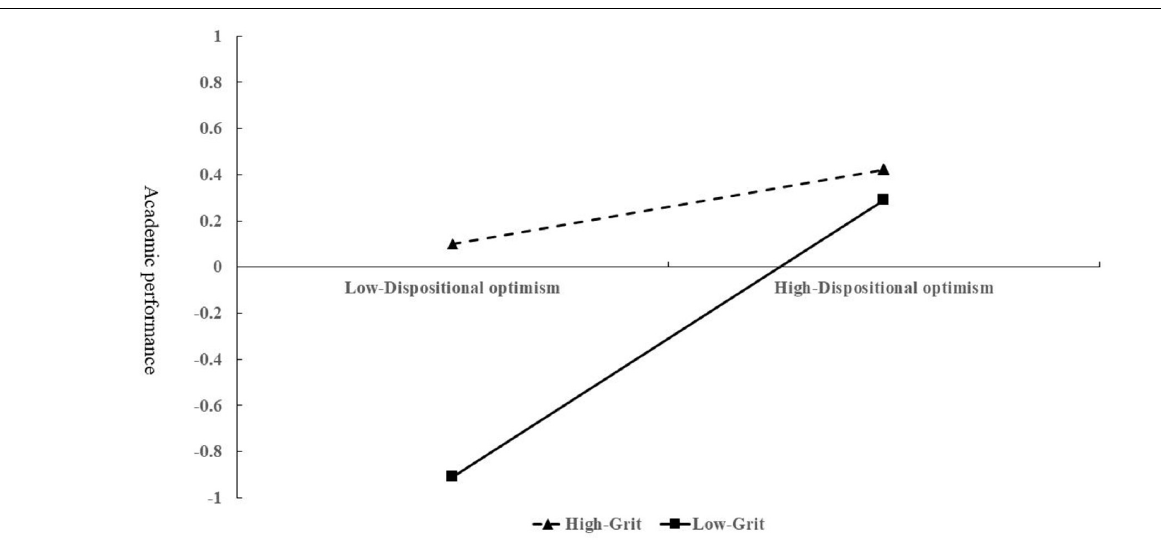
FIGURE 4 | Moderating effect of grit on the relationship between dispositional optimism and academic